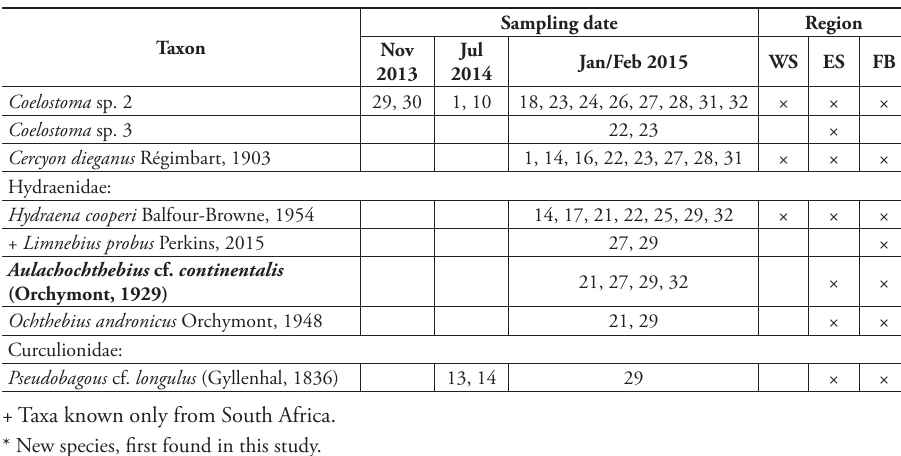
Table 3. Aquatic polyphagan beetles previously recorded from the Lake St Lucia system and surround- ing waterbodies. Literature sources are indicated by letters as follows: (a) Day et al. (1954); (b) Millard and Broekhuysen (1970); (c) Vrdoljak (2004); and (d) Perkins (2014). Museum and national collection material is as follows: SANC – South African National Collection of Insects; ISAM – Iziko South